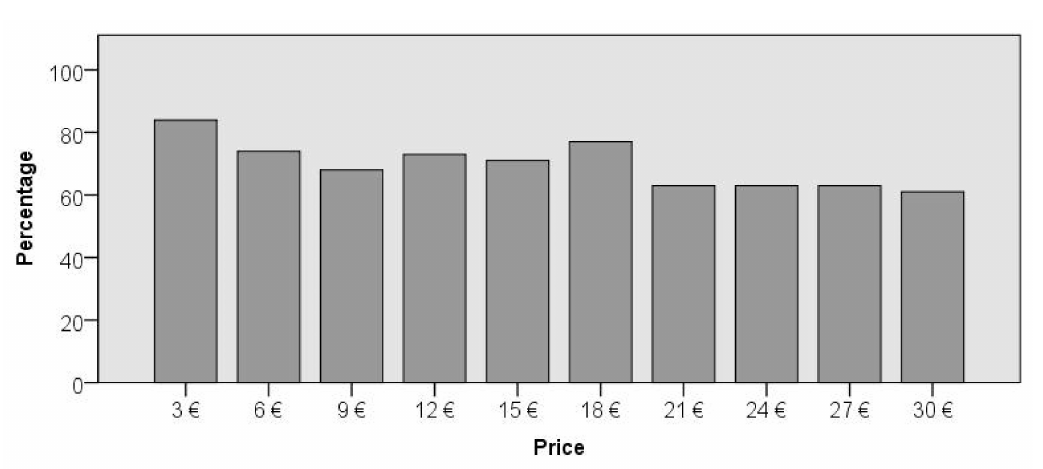
Figure 1. The percentage of respondents’ number who are willing to pay a given price. Source: own processing based on obtained